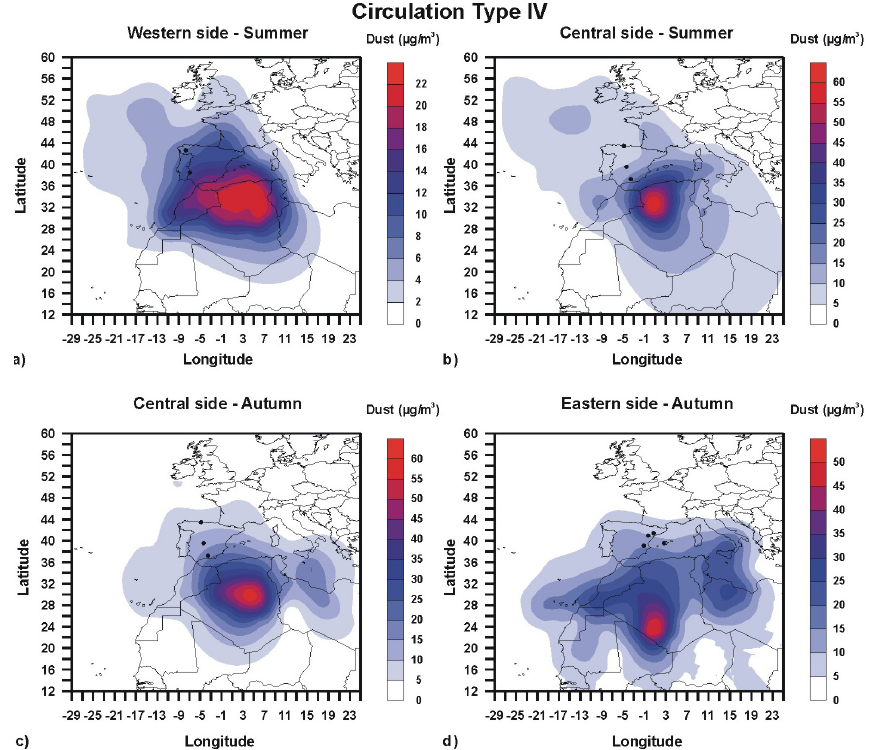
Figure 13. RCFs for African dust contributions (µgm − 3 ) during ADO generated by circulation type IV over the western, central and eastern sides of the area of study in summer and